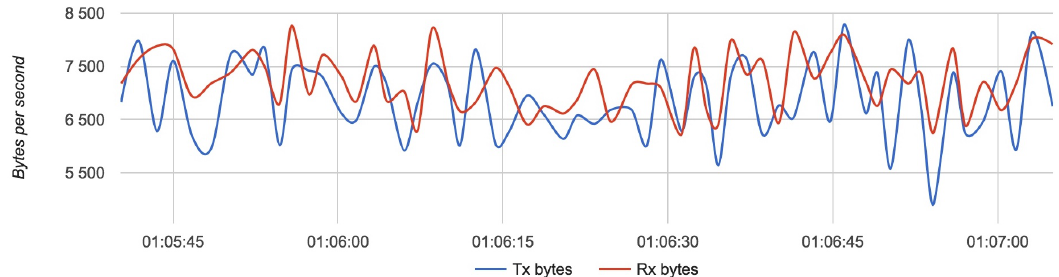
Figure 29. TX/RX difference with packet